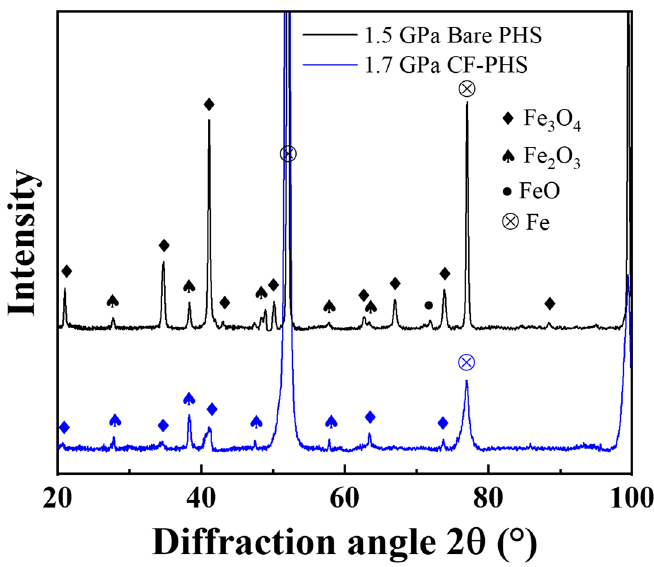
Figure 5. Diffraction pattern of 1.7 GPa coating-free steel and 1.5 GPa bare steel after oxidizing at 930 °C for 340 s.